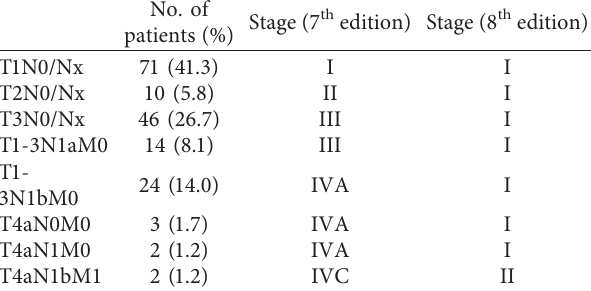
Table 3: Staging of the 172 patients treated for differentiated thyroid carcinoma (DTC) according to the 7 th and 8 th editions of AJCC-TNM staging system.